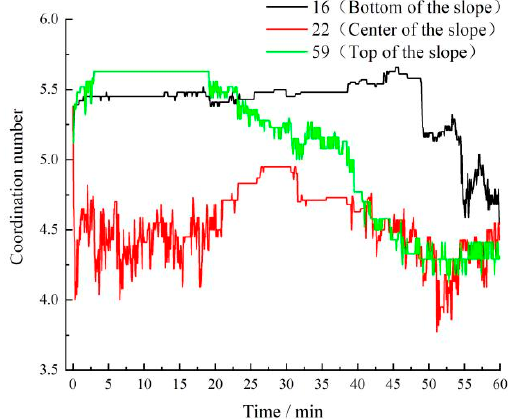
Figure 13. Variation in coordination number in No. 3 gully with time.